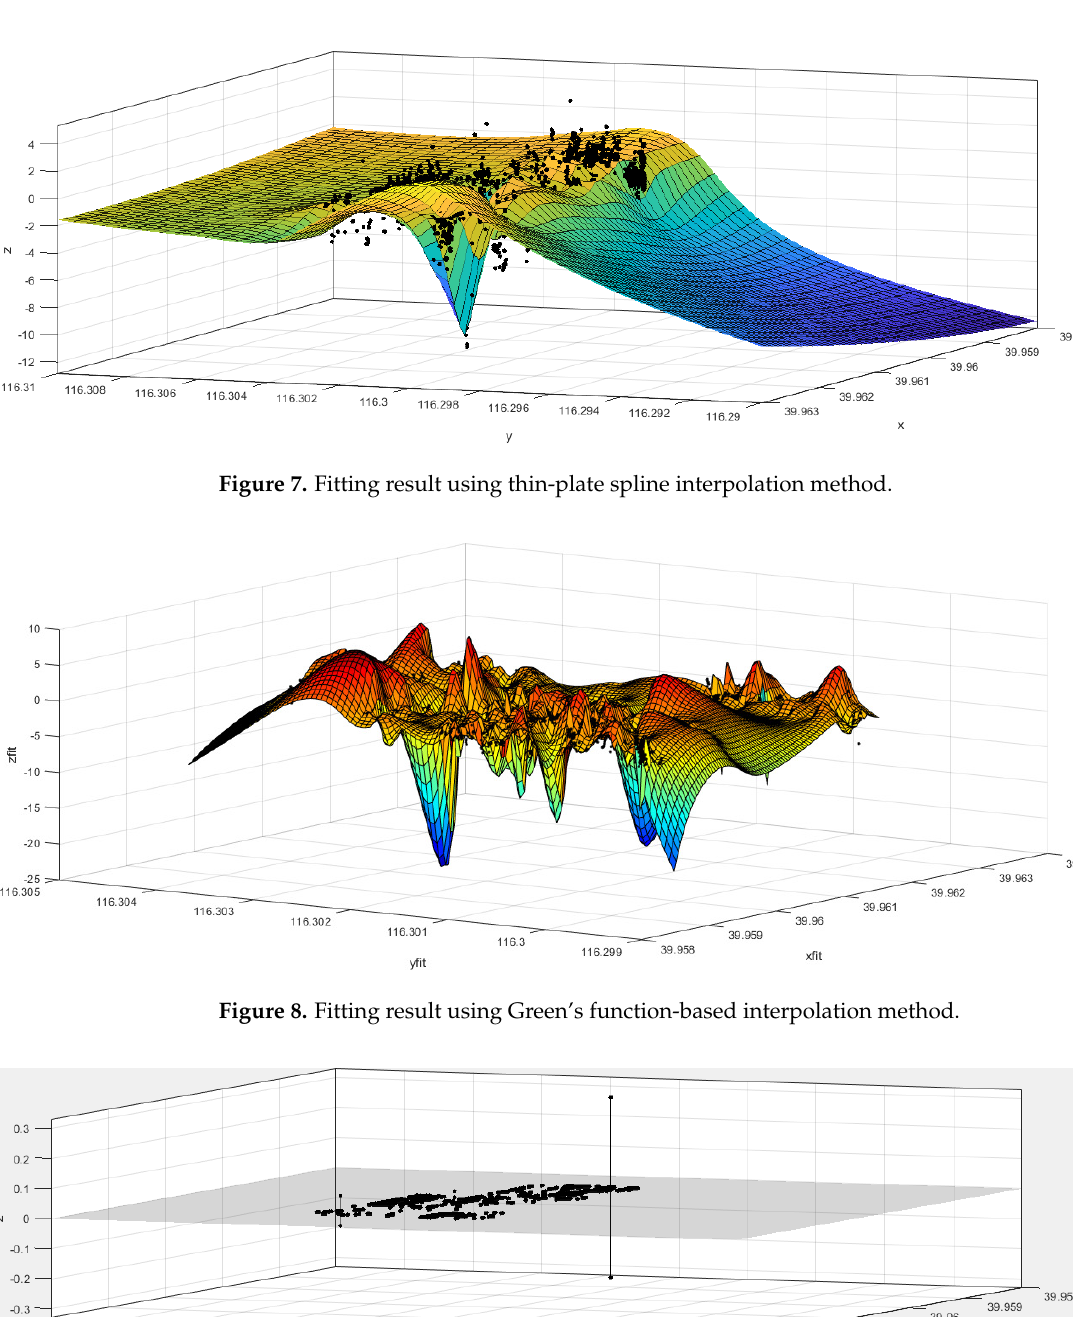
Figure 6. Fitting result using quadratic polynomial surface interpolation method.